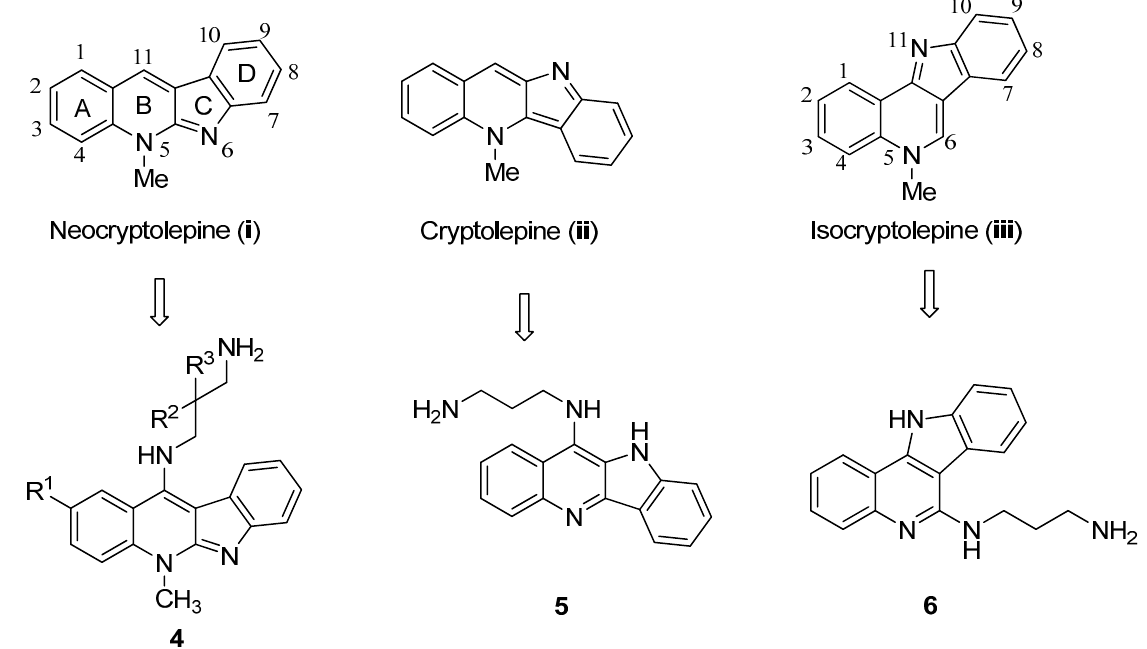
Figure 2. Structures of indoloquinolines from Cryptolepis sanguinolenta and their